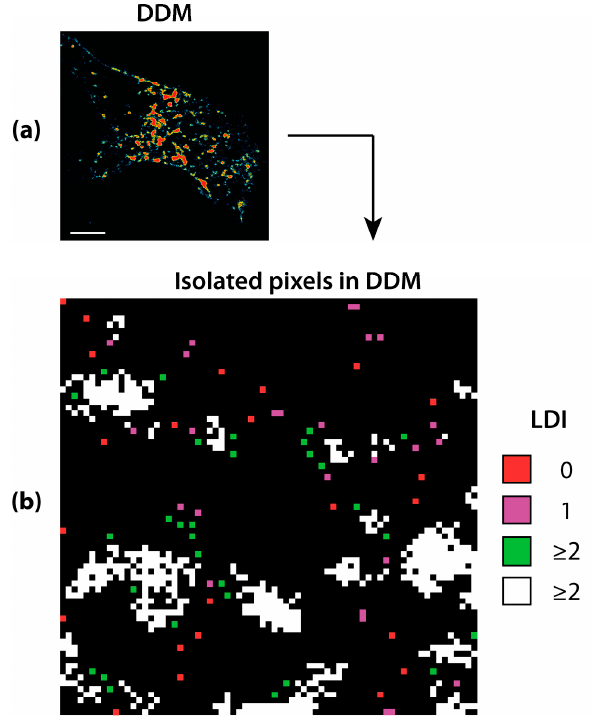
Figure 2. DDM mask creation. The acquired COL7 image is firstly segmented and the DDM ( a ) is then created with a 5 × 5 search window, that is the minimal window size that allows discriminating single pixels based on their locality ( b ) Pixels semantics: (1) isolated red pixels, with LDI = 0; (2) green pixels, isolated, but not alone in their 5 × 5 neighborhood, with LDI ≥ 2; (3) either isolated or “end-point” purple pixels, with LDI = 1; (4) connected white pixels, with LDI ≥ 2. Scale bar: 5 µm. Starting from a grey level input image from COL7 dataset and after an independent binarization procedure, the DDM is created (Figure 2a). Figure 2b shows how differently single and isolated pixels are semantically treated. Here, red isolated pixels are those having LDI = 0, while green isolated pixels have LDI = 2 or greater, as well as the white ones. Finally, purple pixels, with LDI = 1 may be either isolated or “end-point” towards no-density space. Isolated red pixels have no connections with any object in their 5 × 5 neighbors and are the best candidate to be removed since they do not apparently retain any information. On the contrary, it can be seen that green pixels are isolated, but not alone, suggestive to belong to structured though fragmented objects that should hence be kept. This is an example of semantic membership assignment of pixels based on their neighbor’s information. As LDI is function of single pixels, the objects can be composed of pixels with different LDI = 1, as it happens for all the white pixels. However, with a 5 × 5 window, aggregates of two pixels can be subject to an uneven behavior. In fact, depending on whether the aggregate is nearby a structured object or not, they can have one or both pixels with LDI = 1, respectively. Nevertheless, if undesirable this behavior can be modified with ad-hoc